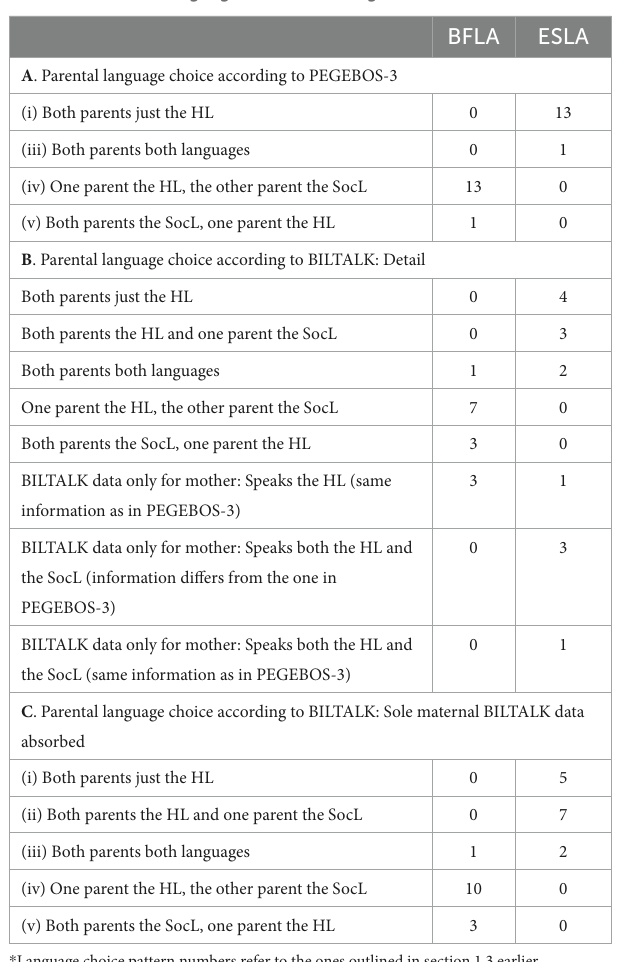
TABLE 11 Parental language choice with target children * .